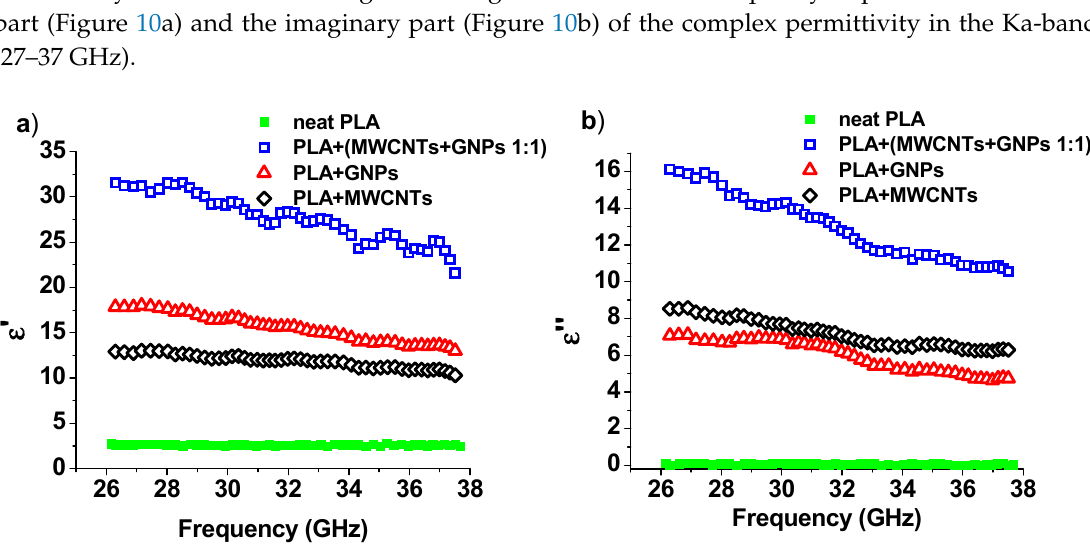
Figure 10. Relative complex permittivity as function of the frequency: Real and imaginary parts in ( a ) and ( b ), respectively.